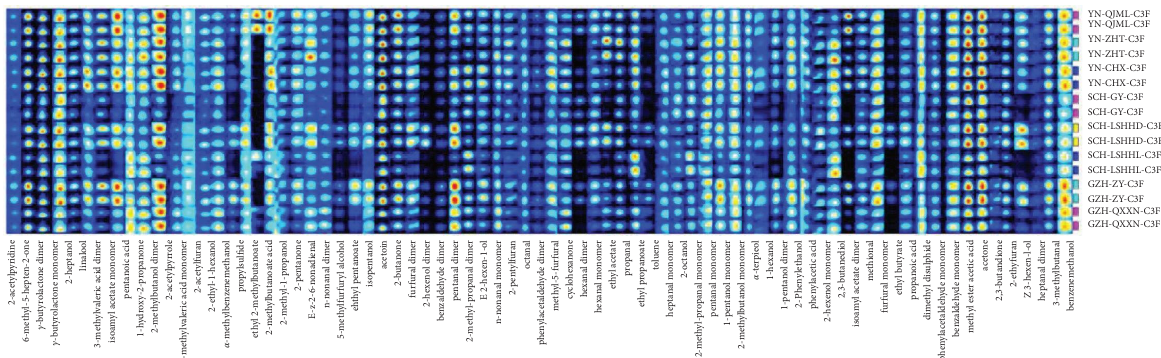
Figure 3: Te fngerprint spectrum of aroma compounds in the tobacco samples from eight producing areas.